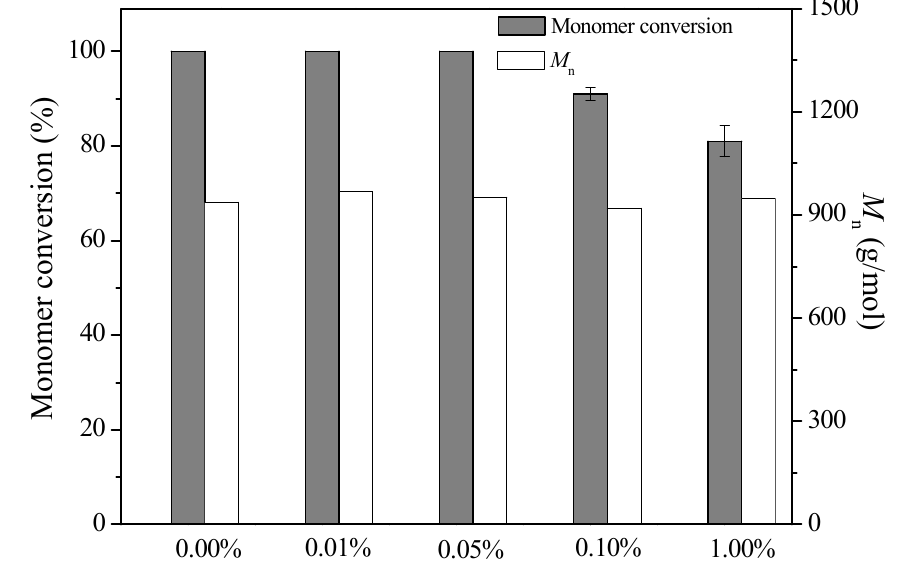
Table 1. Effects of organic solvents on monomer conversion and product molecular weight M